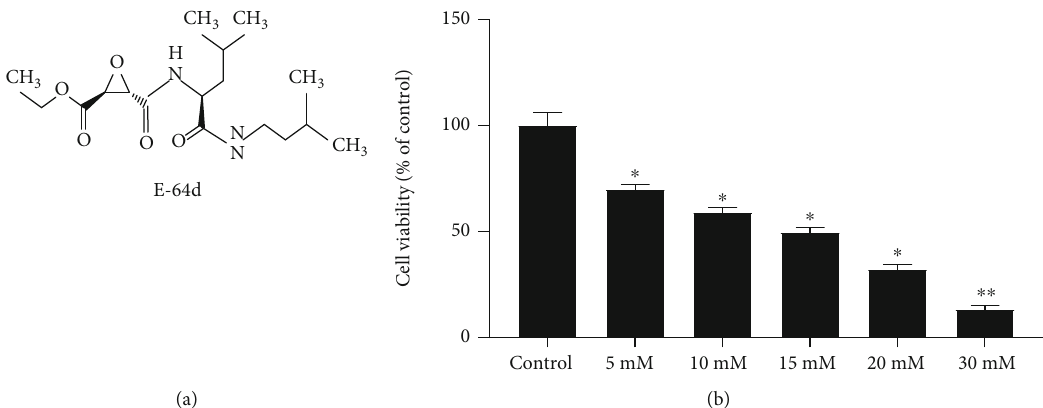
Figure 1: Glutamate induced injuries in HT22 cells. HT22 cells were treated with 5mM to 30mM glutamate for 24 hours. (a) Structure of E- 64d. (b) Cell viability was evaluated via CCK-8. The data are expressed as the mean ± SD . ∗ P < 0 : 05 vs. the Control group. ∗∗ P < 0 : 01 vs. the Control